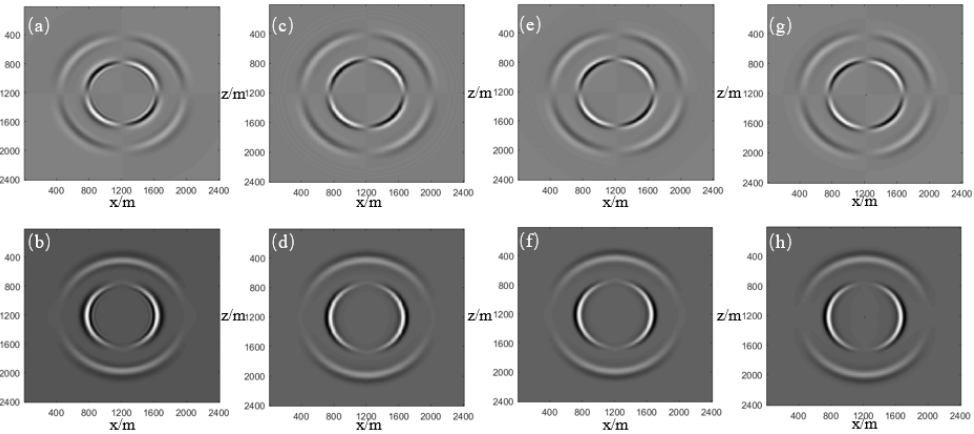
Figure 6. 400 ms wavefield of homogeneous model. ( a ) 2nd ‐ order GFDM X component; ( b ) 2nd ‐ order GFDM Z component; ( c ) 4th ‐ order GFDM X component; ( d ) 4th ‐ order GFDM Z component; ( e ) SGFD X component; ( f ) SGFD Z component; ( g ) Analytical solution for the X component; ( h ) Analytically solved Z component.